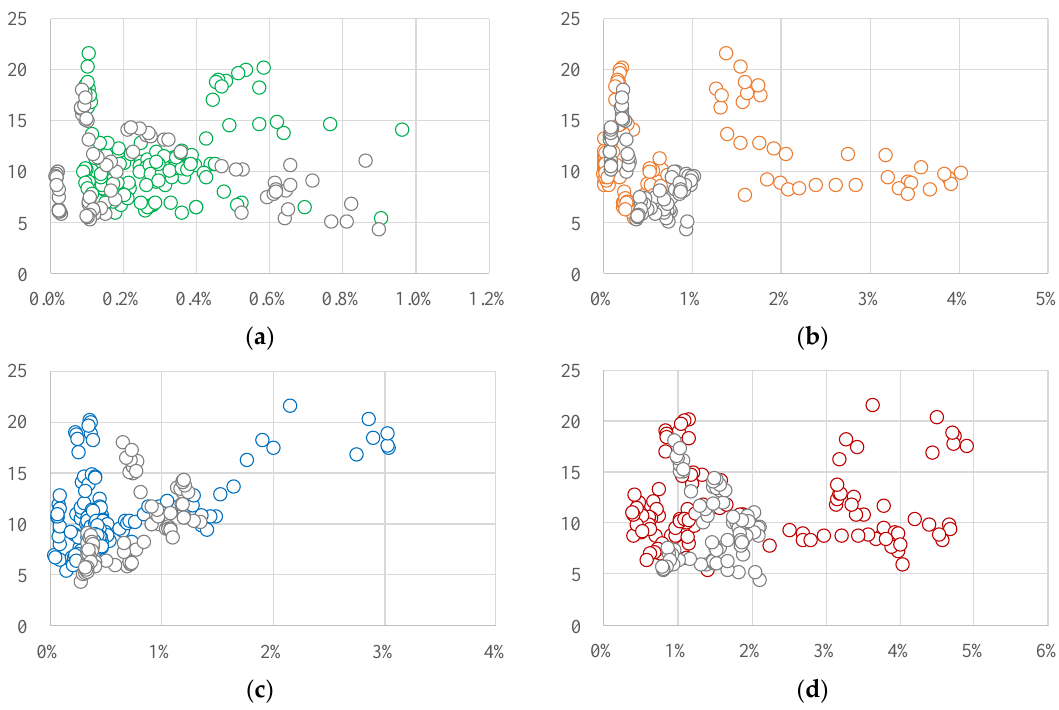
Figure 3. The scatter plot of labor productivity (LP) and information and communications technology (ICT) capital share. ( a ). Information Technology (IT) capital share; ( b ). Communication technology (CT) capital share; ( c ). Software capital share; ( d ). Share of total ICT capital. Note: The vertical axis shows the LP and the horizontal axis shows the capital share in gross capital stock. Grey color represents countries with a large economic scale.